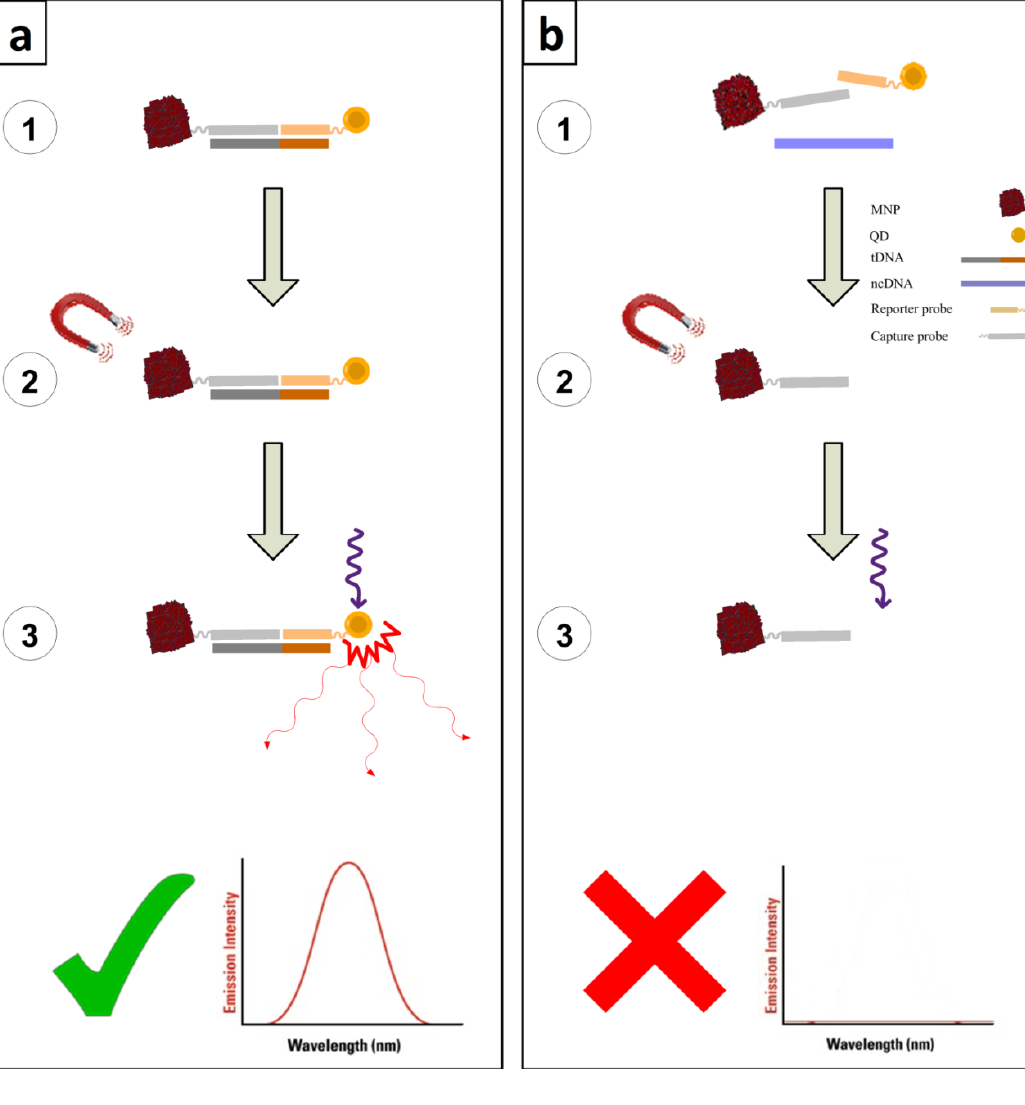
Figure 1. Schematic diagram of the mechanism of the designed optical DNA nanosensor and the related fluorescence spectra. Three different steps of the process are numbered in the diagram. ( a ) In presence of complementary tDNA ( b ) In presence of non-complementary